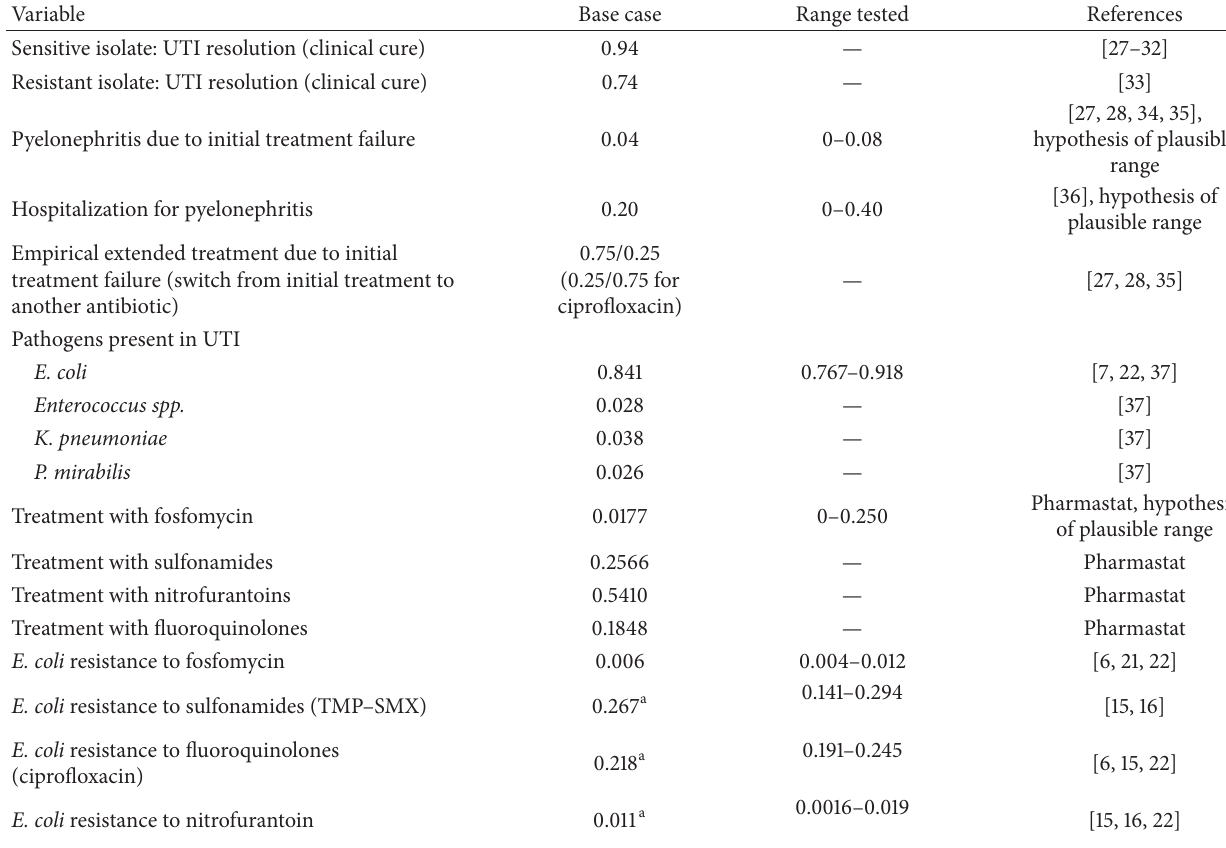
Table 2: Probability values used in the model for decision-tree nodes and ranges used in the sensitivity